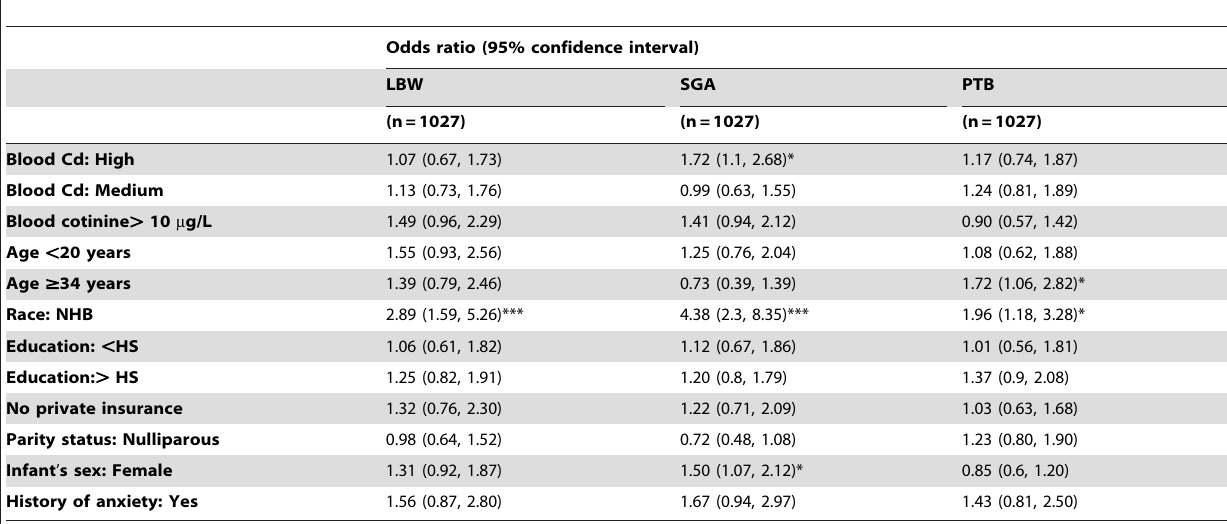
Table 4. Adjusted odds ratios and 95% confidence intervals for dichotomous birth